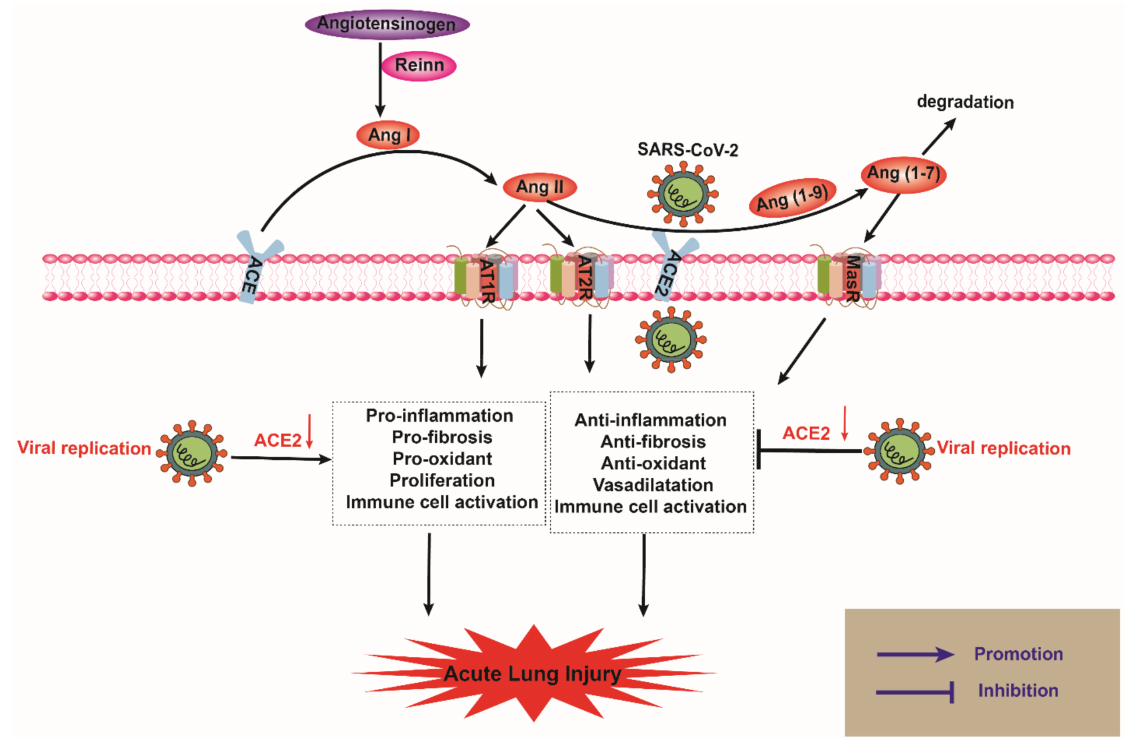
Figure 1. Current view on the renin angiotensin system (RAS) and development of ALI in COVID-19. RAS consists of classical and non-classical axes. ACE is a component of the classical axis, which converts angiotensin I (Ang-I) to Ang-II, and the latter binds to AT1 or AT2 receptors. The non-classical RAS axis contains ACE2, which hydrolyzes Ang II to produce Ang-(1-7). Ang-(1-7) has affinity with the Mas receptor (MasR), and they altogether form the ACE2/Ang-(1-7)/MasR axis, which can regulate the ACE/Ang II/AT1R axis. When lung tissues are infected with SARS-CoV-2, the virus binds with ACE2 receptor on the cell membrane and downregulates its expression, causing Ang II to activate the AT1 receptor and promote ALI. The red arrow indicates a